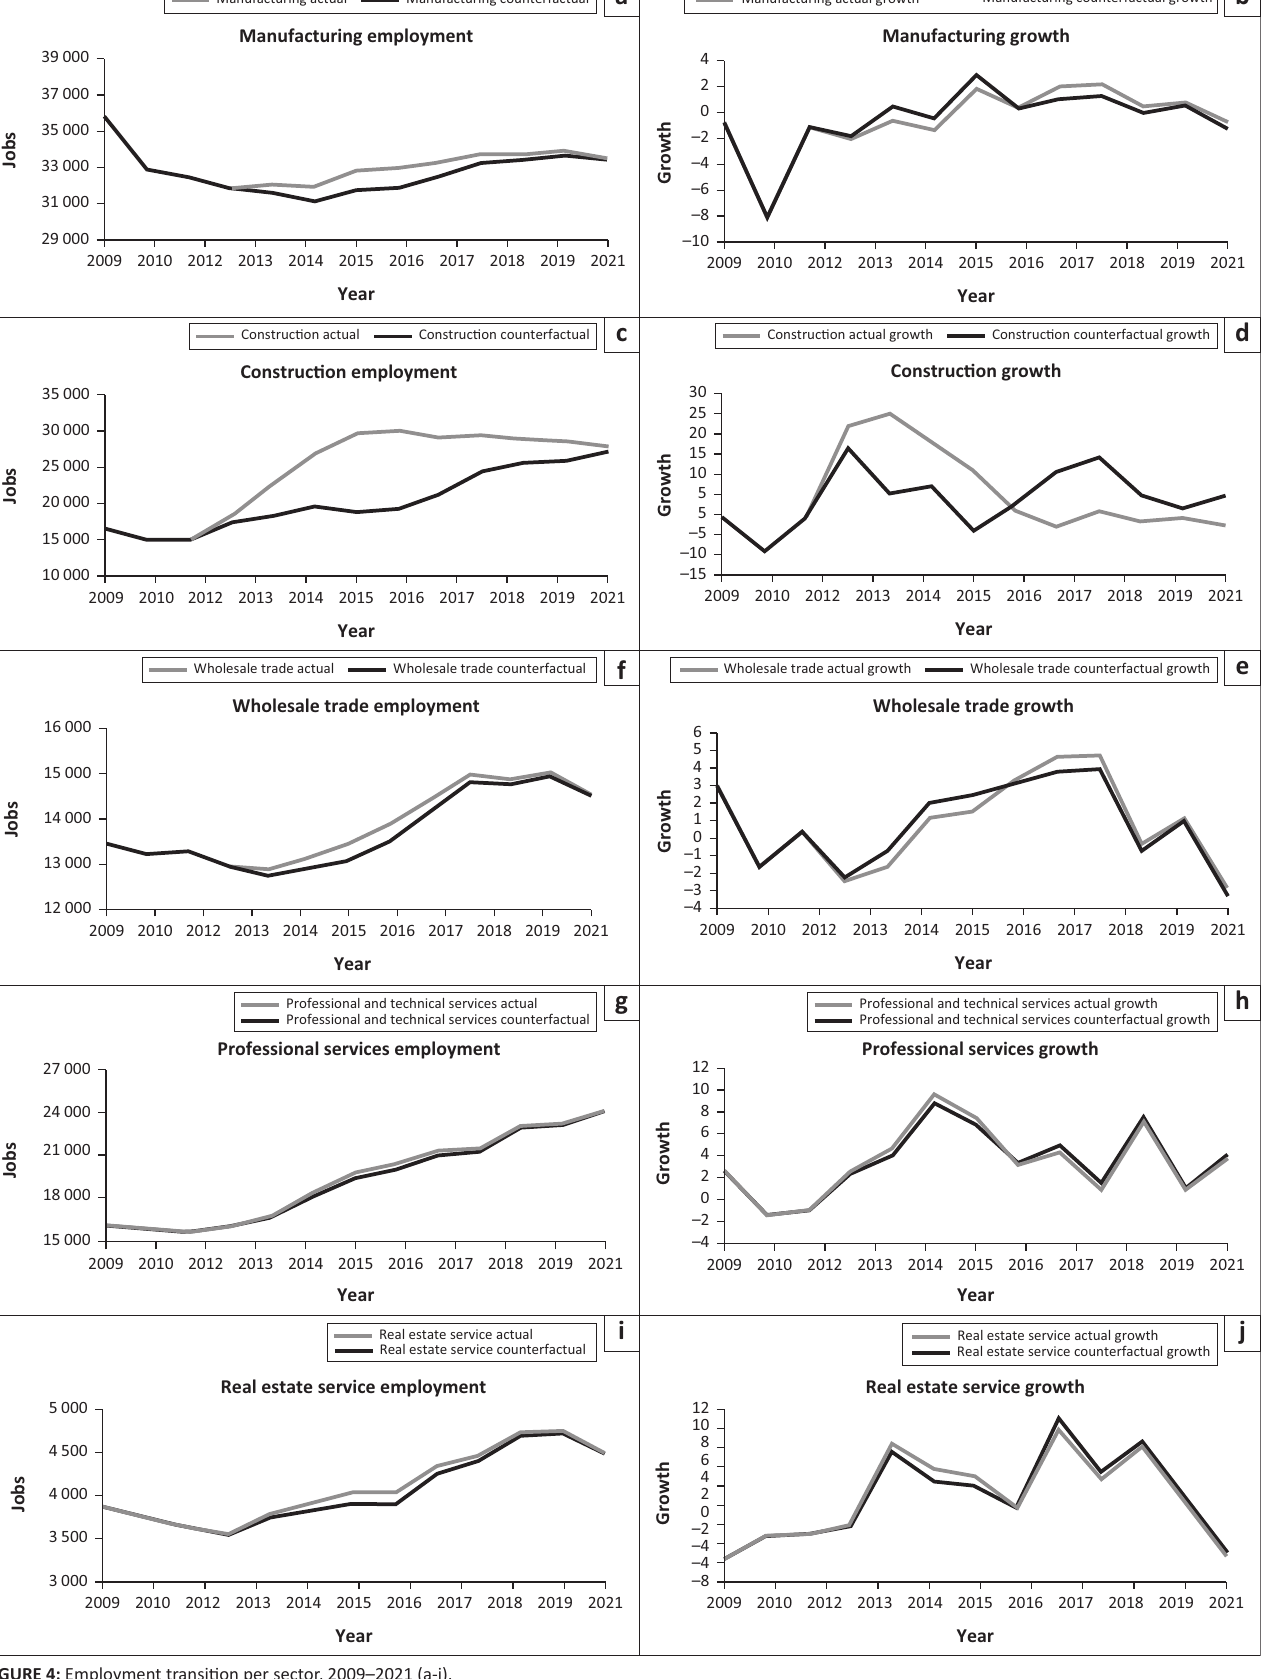
FIGURE 4: Employment transition per sector, 2009–2021